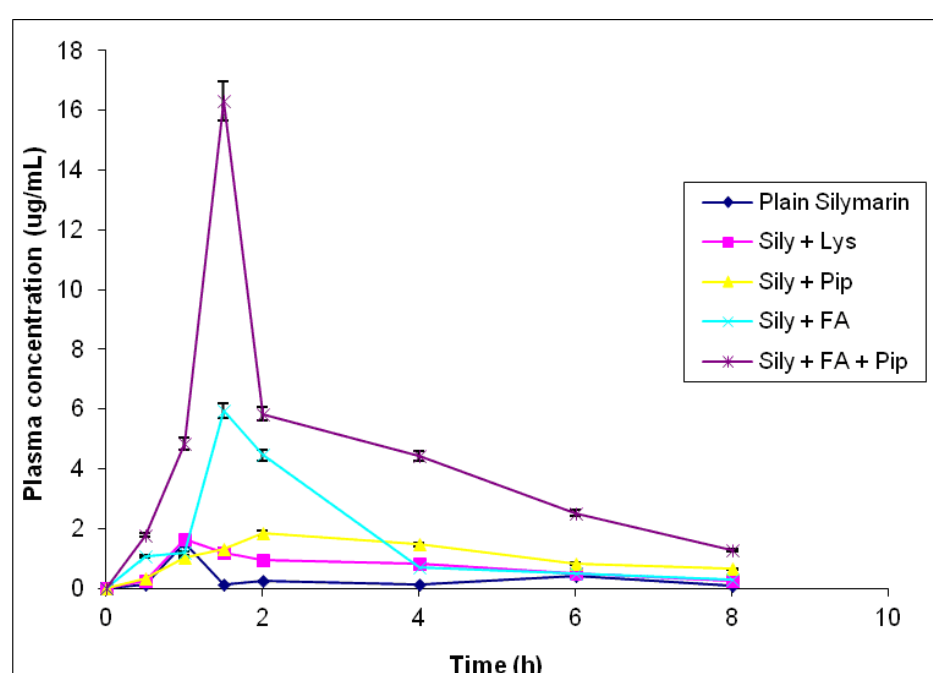
FIGURE 3 - Mean (± S.E.M) plasma concentration versus time curve of a single oral dose (140 mg/kg) of control and silymarin with bioenhancer formulations in rats (the standard error bars were omitted from the graph for the better elucidation of the pharmacokinetic profiles). TABLE II - Pharmacokinetic parameters of all silymarin formulations obtained in rat plasma (Mean ± SEM, n = 6)